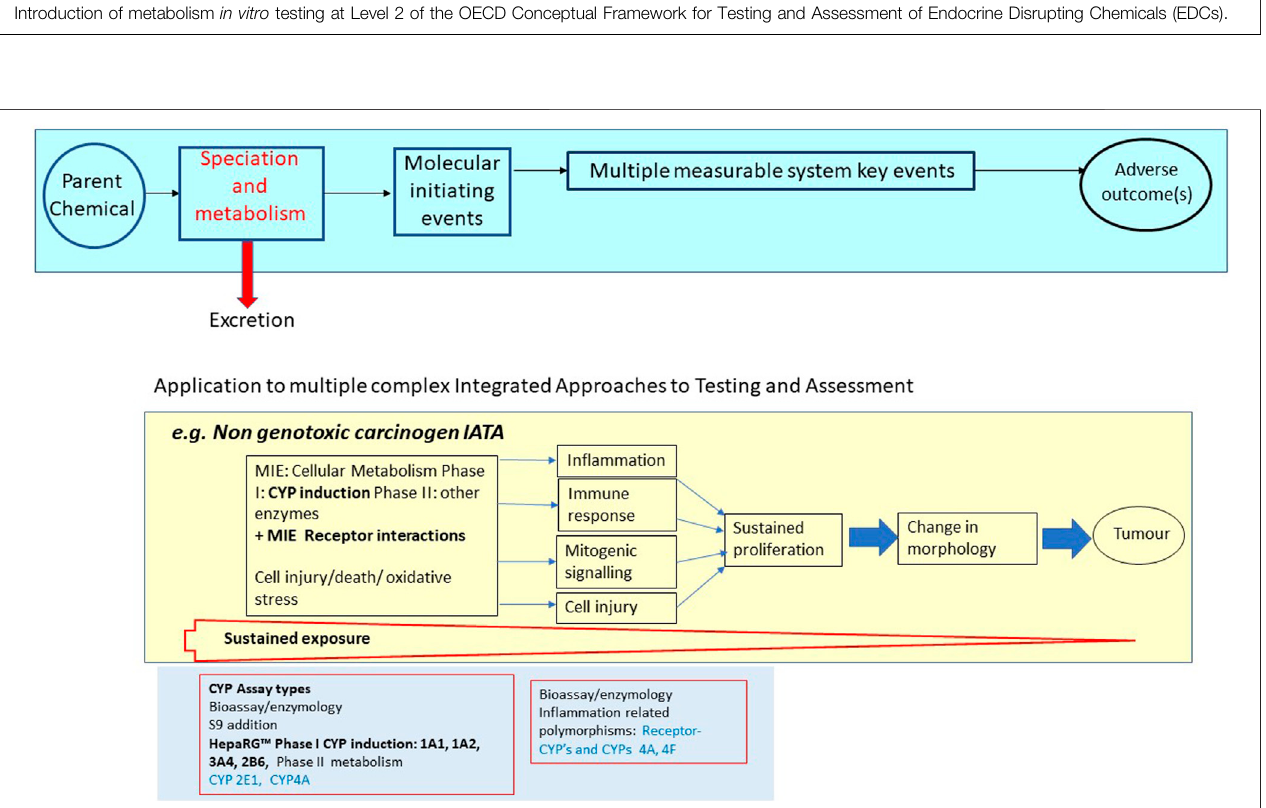
Frontiers in Toxicology |